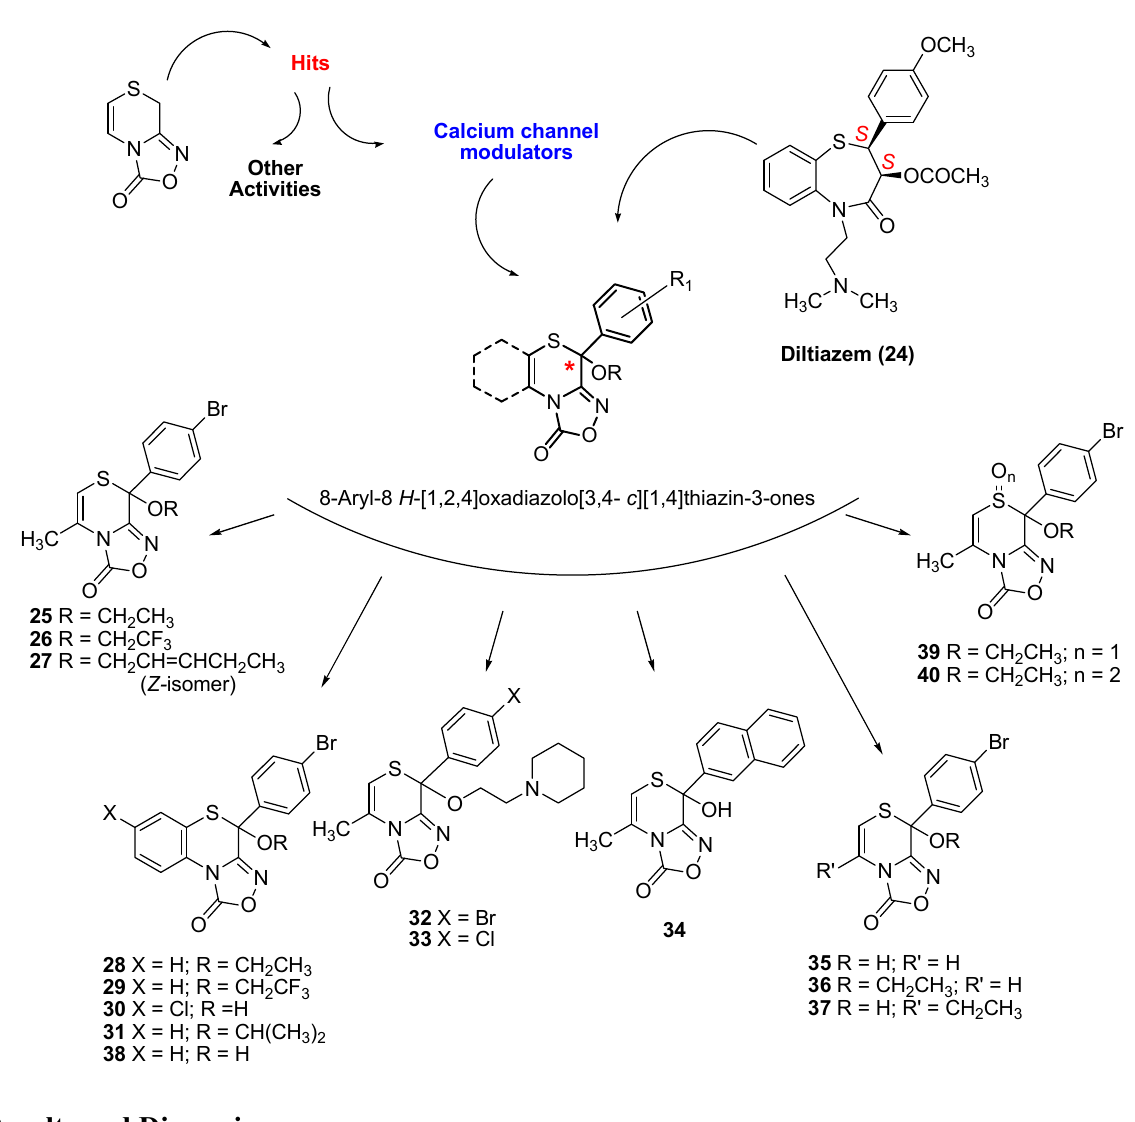
Figure 1. Structure of diltiazem ( 24 ), of published (compounds 25 – 29 , 38 ) and novel oxadiazolothiazinone derivatives (compounds 30 – 37 , 39 , 40 ), whose LTCC data is presented